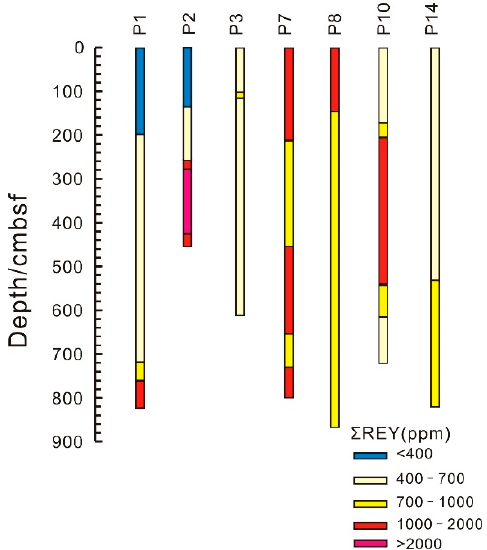
Figure 4. REY contents of typical piston cores in the study area.